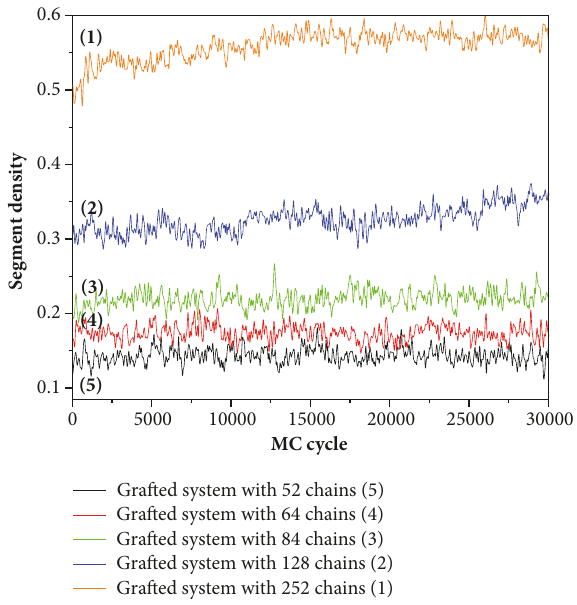
Figure 6: < 𝑅 2 𝑔 > for the relaxed grafted systems before the crystallization process with 52, 64, 84, 128, and 252 polymer chains, respectively.